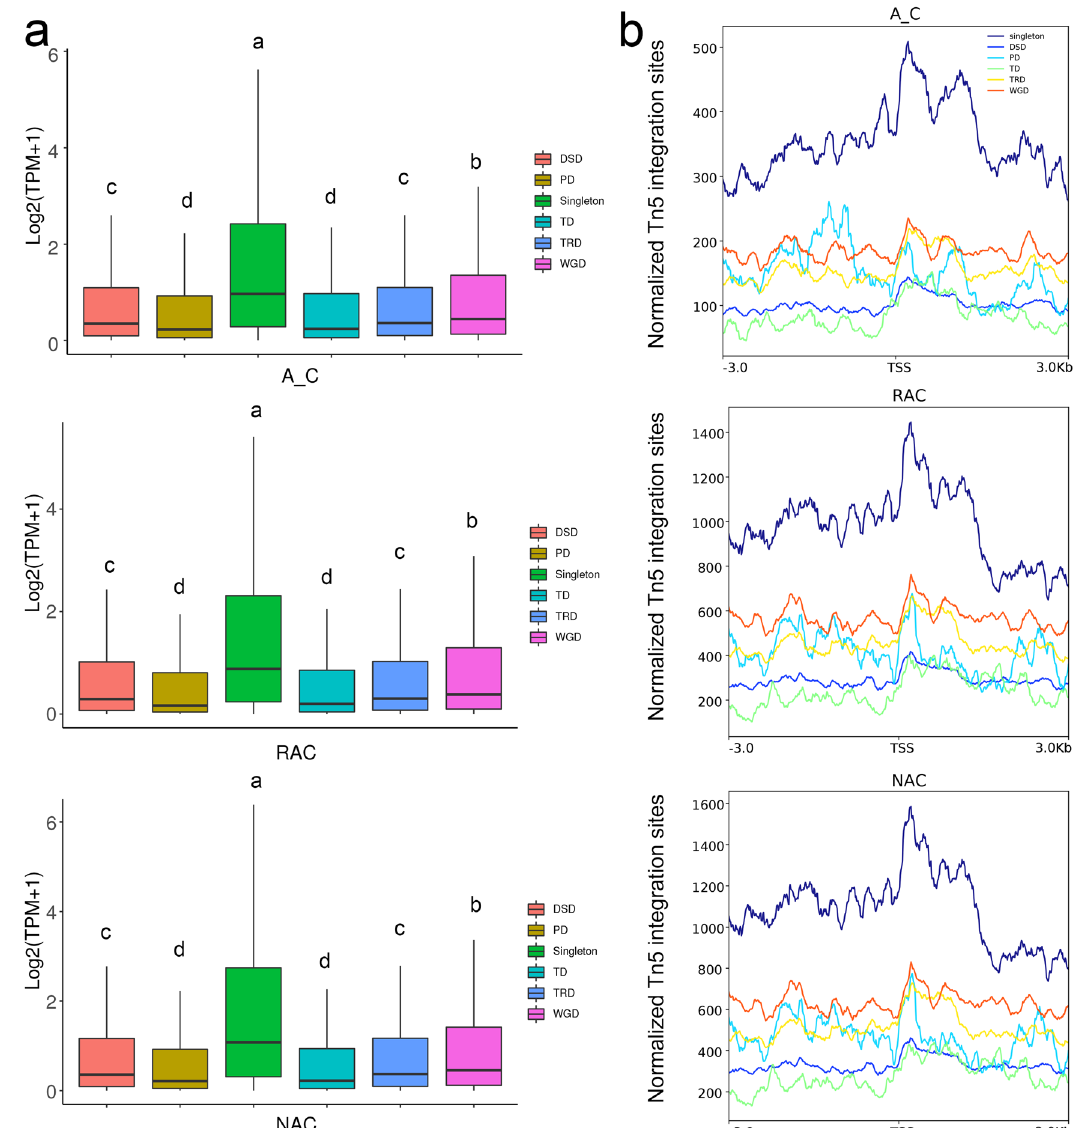
Fig. 10 Gene expression levels and chromatin accessibility of six types of genes. a Gene expression levels of six types of genes. b Chromatin accessibility of six types of genes. A_C, in silico ‘ hybrid ’ ; RAC, resynthesized B. napus ; NAC, natural B. napus ; TSS, transcriptional start site. DSD, dispersed duplication- derived genes; PD, proximal duplication-derived genes; TD, tandem duplication-derived genes; TRD, transposed duplication-derived genes; WGD, whole- genome duplication-derived